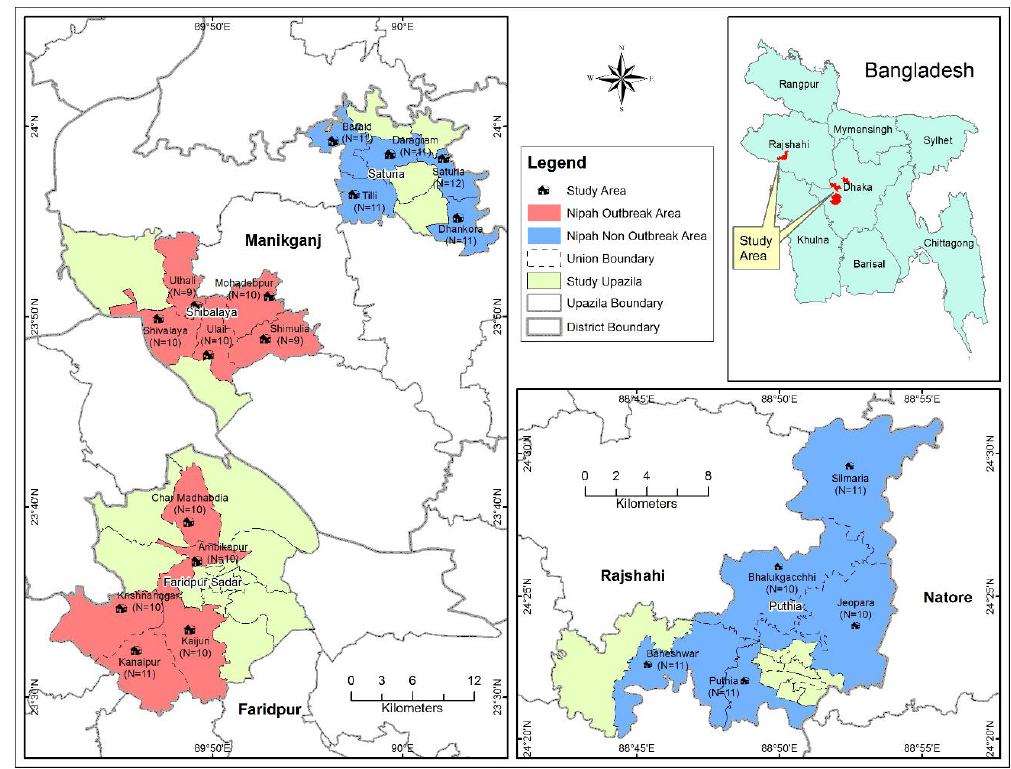
Figure 2. The spatial distribution of the study sites with the number of respondents ( n ) in Nipah outbreak areas (NOAs; depicted in pink) and Nipah non-outbreak areas (NNOAs; depicted in light green). The map was plotted using ArcMap, version 10.2, Environmental Systems Research Institute, Redlands, CA, USA.